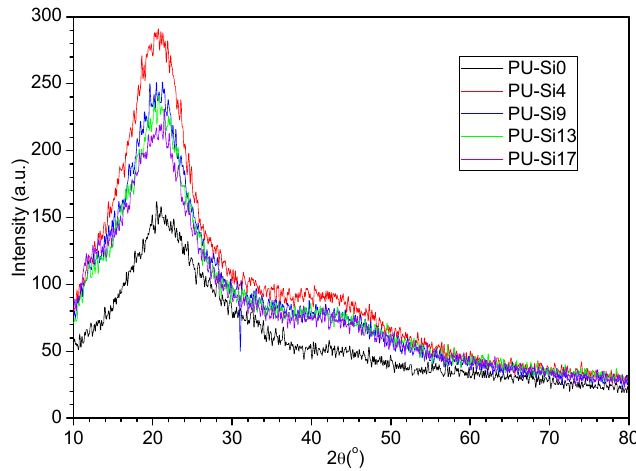
Figure 1. Fourier transform infrared (FTIR) spectra of the PU-Sis samples: ( a ) wave number from 4000 to 600, ( b ) wave number from 2000 to 600 local amplification of ( a ).